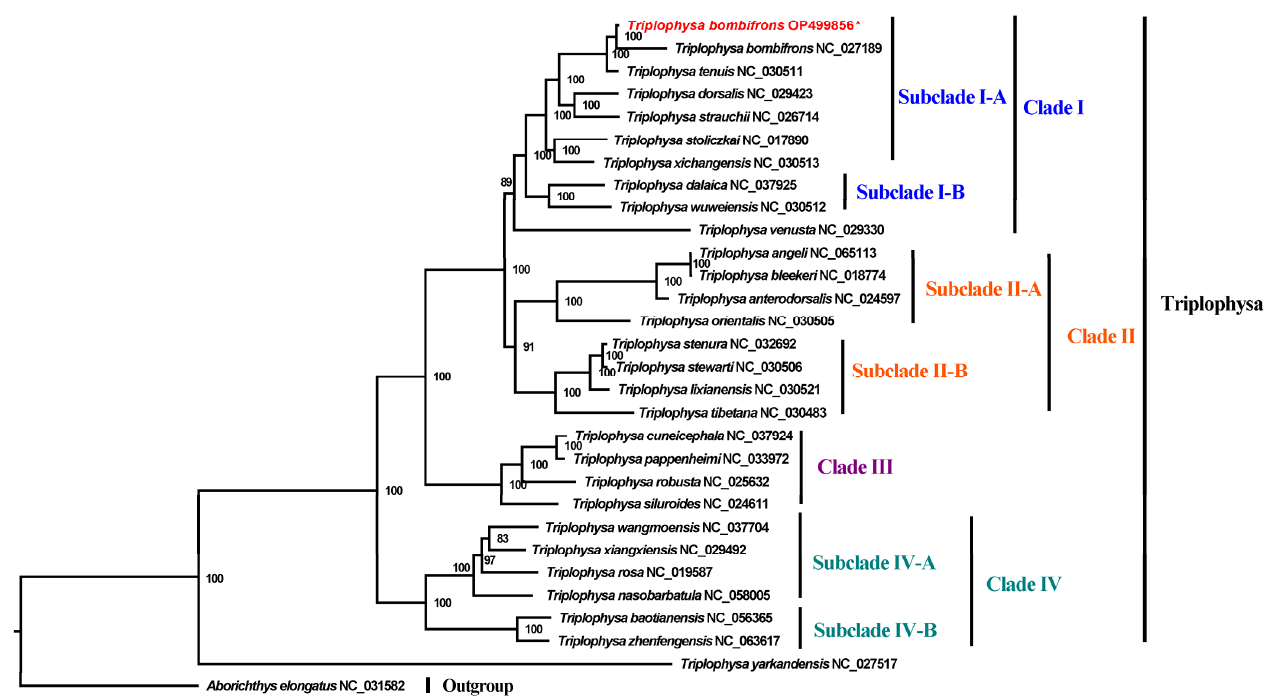
Figure 4. Phylogenetic relationship of 29 Triplophysa mitogenomes inferred by ML analyses, based on 13 PCGs. The number (%) on the branches indicates the maximum likelihood (ML) bootstrap support value. The T. bombifrons in this study was marked in red and asterick (*). Table 2. Annotation of genes in the T. bombifrons mitogenome.